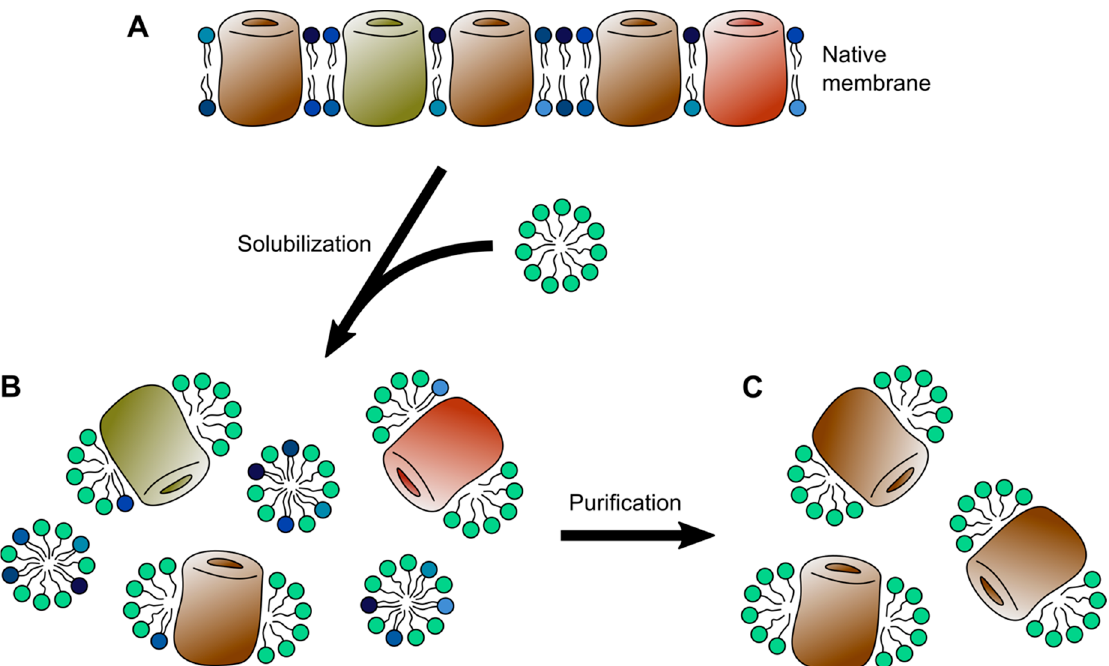
Figure 2. Solubilization and purification of membrane proteins. ( A ) Native membrane containing a membrane protein of interest over a background of other membrane proteins in a diverse lipid composition. ( B ) Mixed membrane protein-detergent and lipid-detergent micelles resulting from solubilization of the membrane through the addition of detergent. ( C ) Purified membrane protein in detergent micelles after removal of undesired lipid components and protein contaminations.